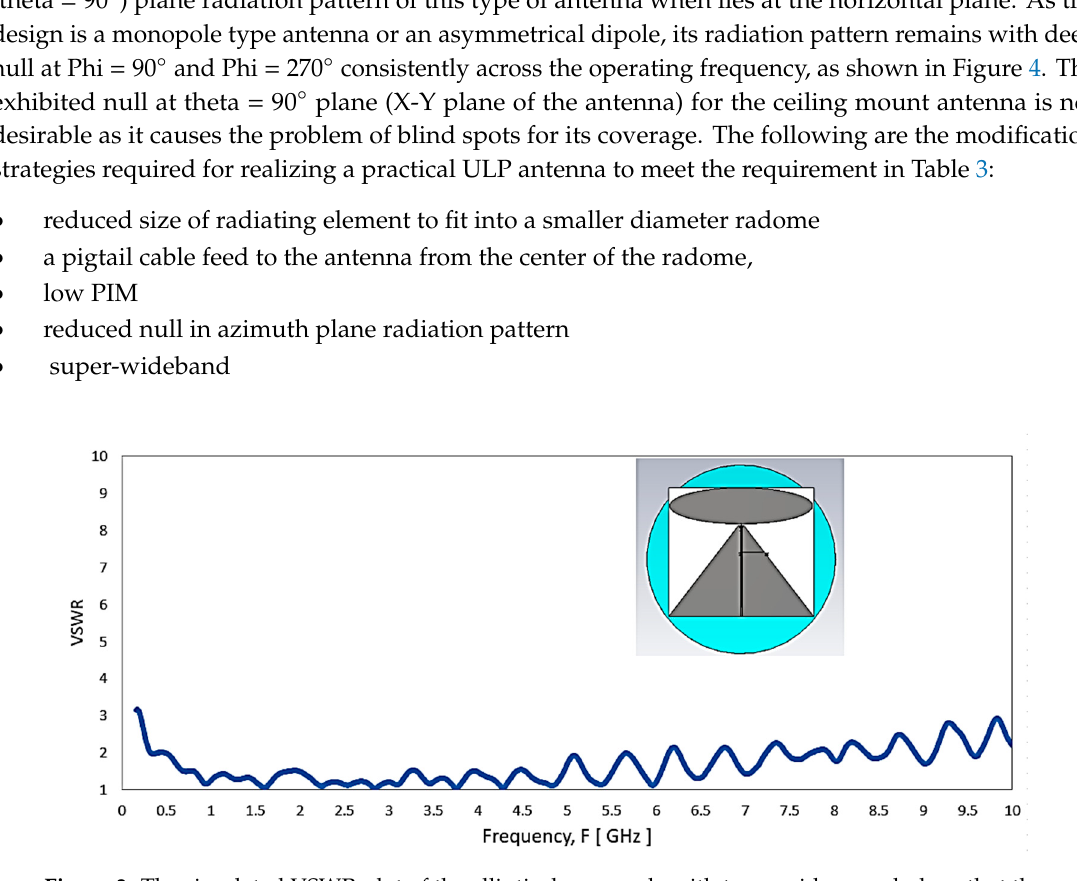
Figure 3. The simulated VSWR plot of the elliptical monopole with trapezoid ground plane that the lowest frequency tweaked to 350 MHz.